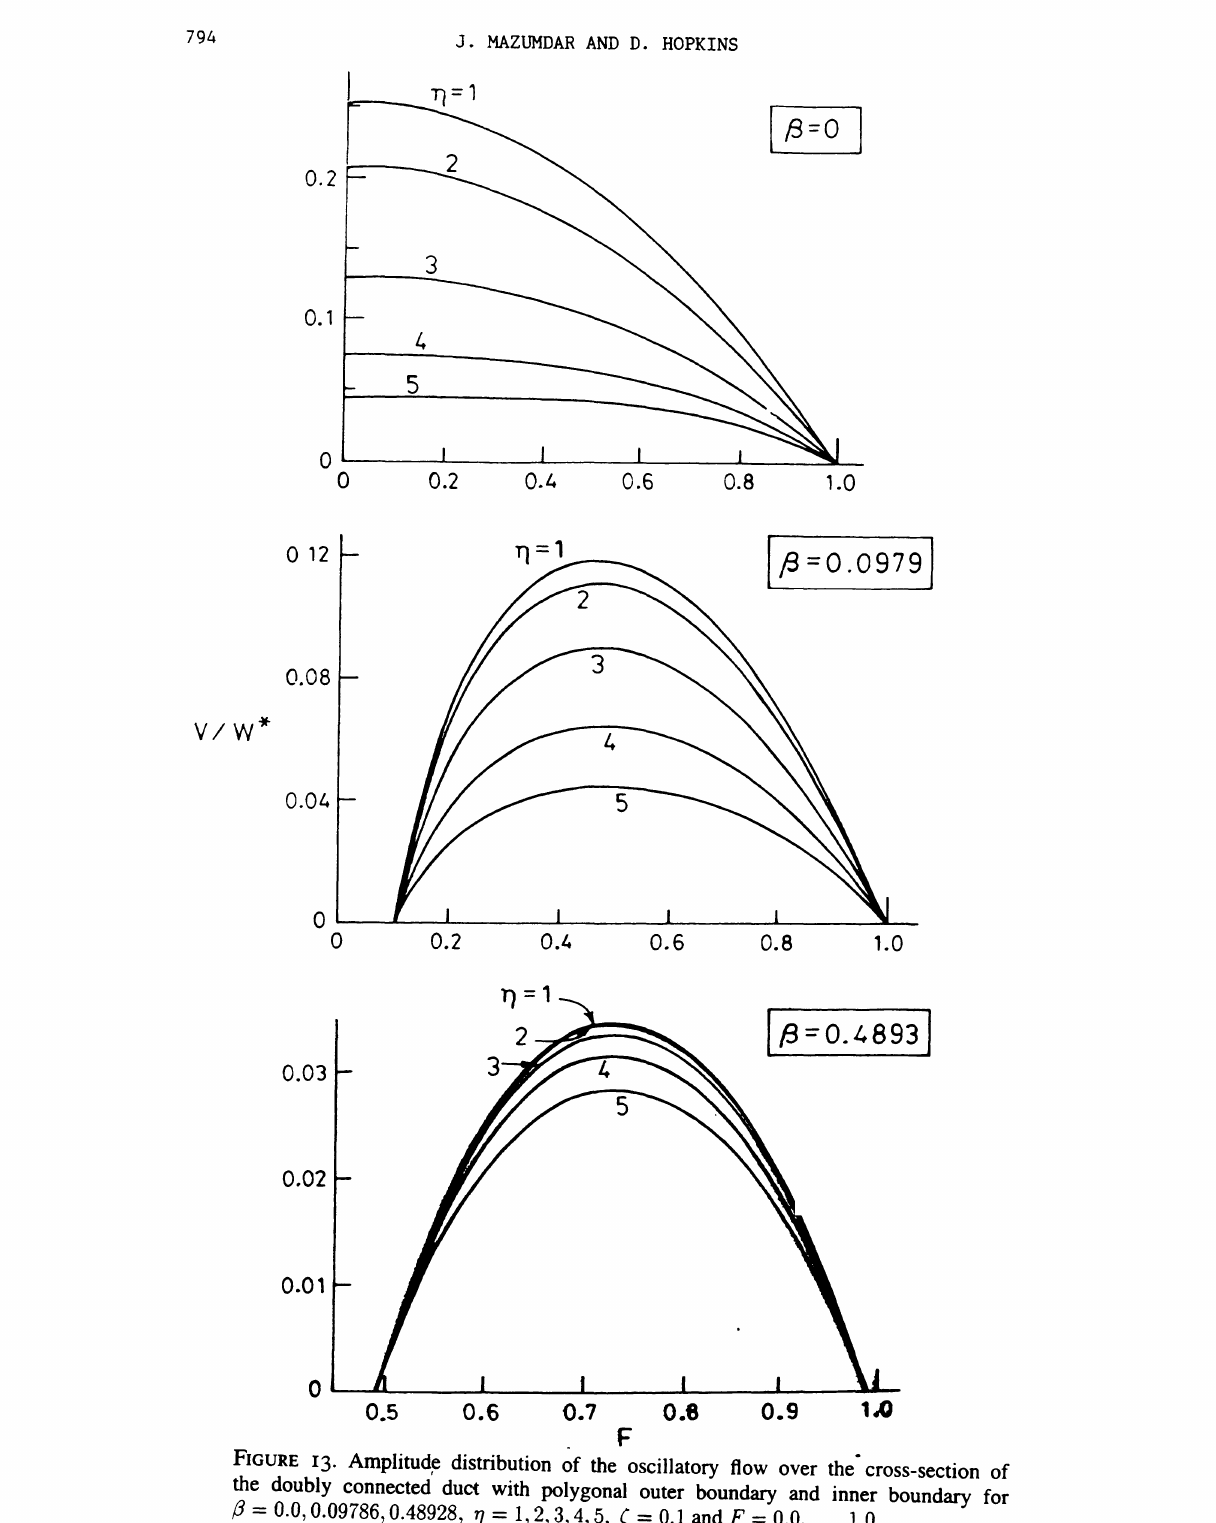
and inner boundary for